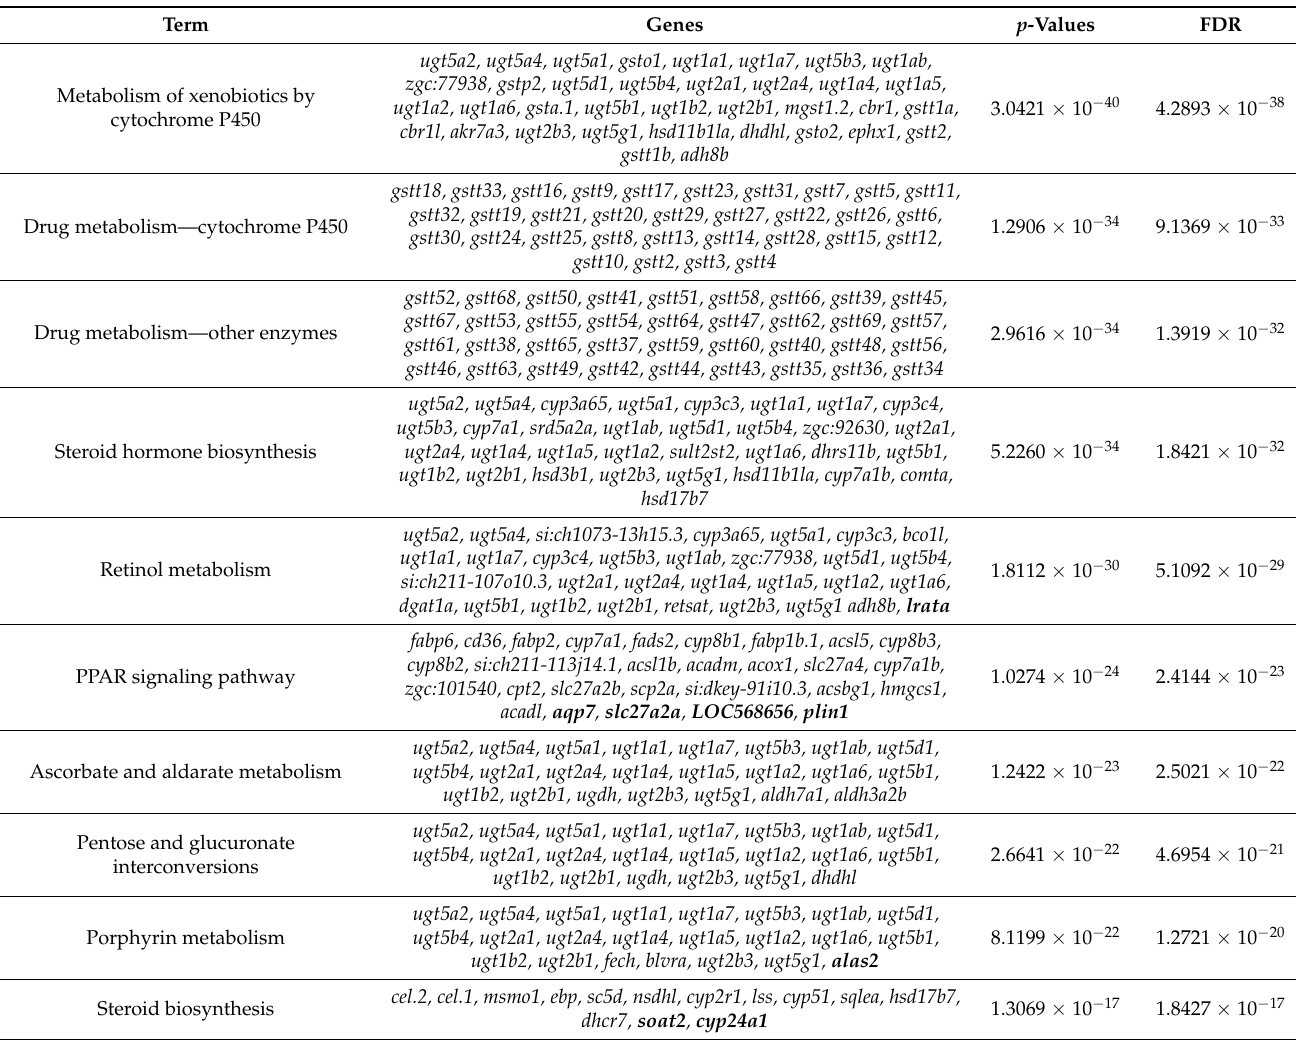
Table 3. List of significant DEGs for each enriched KEGG pathway in the HTZF group.